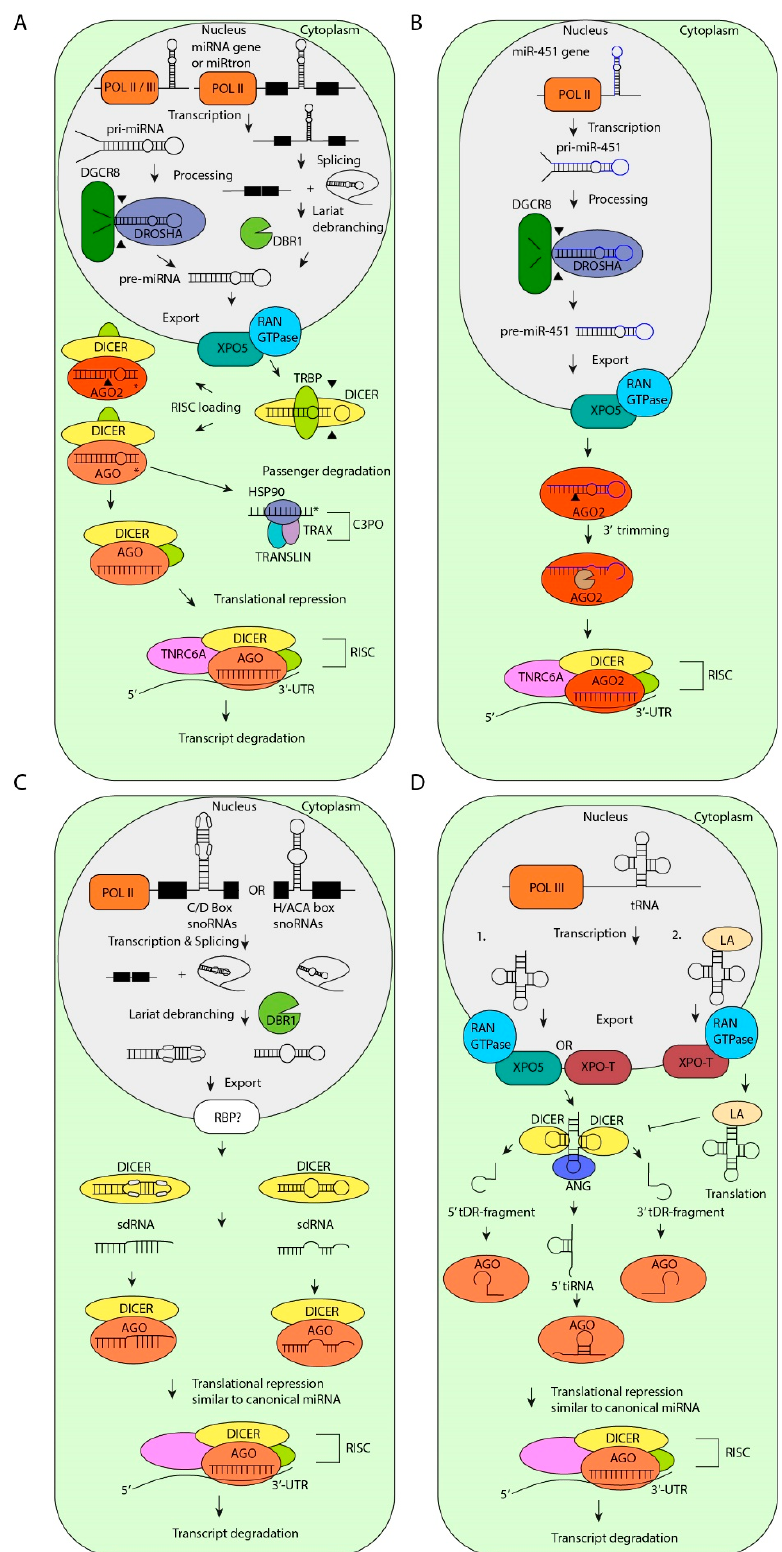
Figure 1. Biogenesis of microRNAs (miRNAs). ( A ) Canonical miRNA biogenesis starts with transcription of miRNA genes by RNA Polymerase II (POL II) or POL III. Next, the primary (pri)-miRNAs are processed by DROSHA/DiGeorge syndrome critical region 8 (DGCR8). The resulting pre-miRNAs are exported to the cytoplasm by Exportin-5 (XPO-5). MiRtrons are spliced out and the intron lariat is debranched by lariat debranching enzyme 1 (DBR1), which results in pre-miRNAs. Once exported, the pre-miRNAs are cleaved by DICER/trans-activation-responsive RNA binding